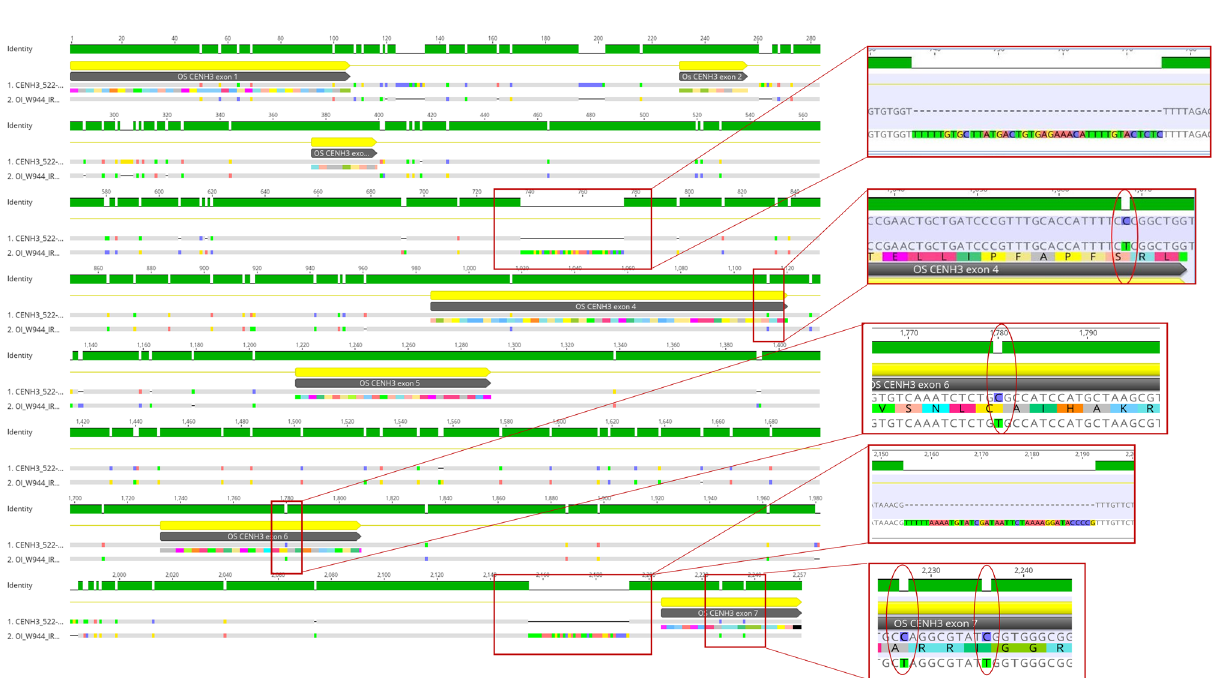
Figure 3. Variations seen solely in O. longistaminata accessions when compared to reference ( a ) Indel found in Intron 3, ( b ) SNP at position168/codon 95, ( c ) SNP at position 1728/codon 138, ( d ) Indel in intron 6 and ( e ) SNPs at codons 155 and 158. Please also refer to Table 2. (The alignment was carried out using Geneious Prime version 2021.1.1; images were generated from Geneious Prime version 2021.1.1 residues. Ten haplotypes were seen in Oryza genus upon aligning and analyzing entire protein length (Table 4). In these ten haplotypes, the major differences arise from changes in NTT, while HFD in many variants is identi- cal. Upon limiting the analysis to just the HFD, five variant types were observed (Table 4). It is noteworthy that O. meyeriana carries the CENH3 variant (A0A6G1EGA2) with most changes (ten) in the HFD region when compared to the reference protein Q6T367 ( Oryza sativa ssp japonica ), which can be attributed to the fact that